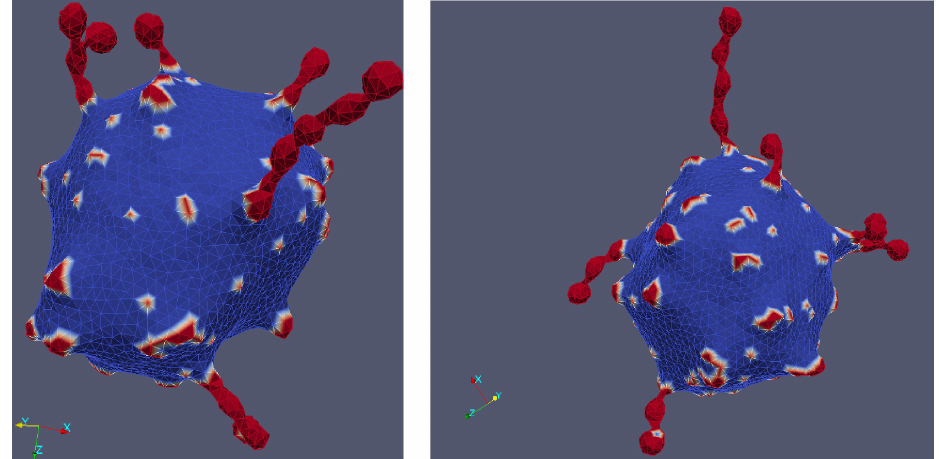
Figure 18. A typical vesicle shape calculated by MC simulations for two-component membrane composed of highly curved isotropic flexible nanodomains (red color) and the nanodomains with zero intrinsic curvature (blue color). Membrane nanodomains with high intrinsic curvature (red color) are accumulated in undulated membrane protrusions. Adapted with permission from ref. [23]. 2017 Springer